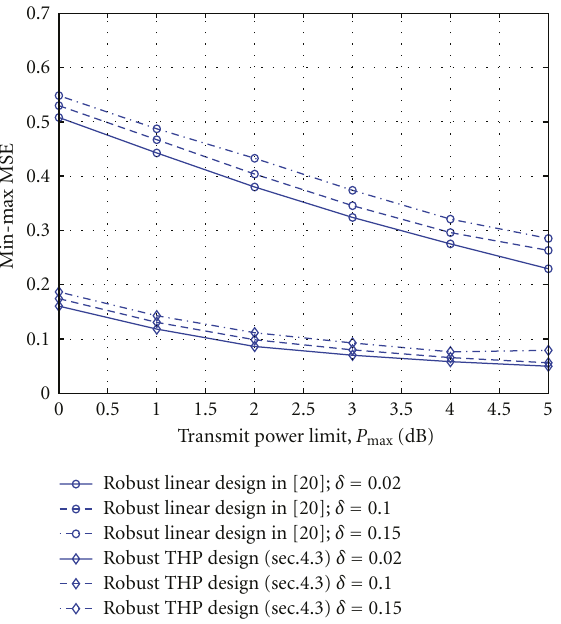
Figure 9: Min-max MSE versus total BS transmit power limit, P max , in the proposed robust design in Section 4.3 for the NBE model. M = 2, N N L N = L = 2, δ = δ = t = 4, r 1 = r 2 = 2, 1 2 1 2 δ = 0 . 02,0 . 1,0 . 15. Proposed robust THP transceiver design in Section 4.3 performs better than the robust linear design in